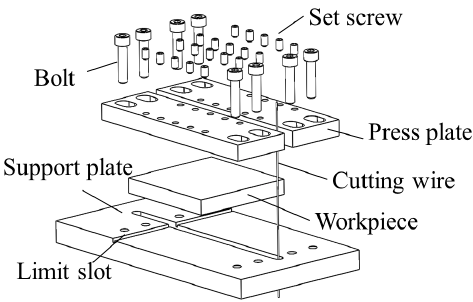
Figure 2. Schematic diagram of specimen size and cutting surface.